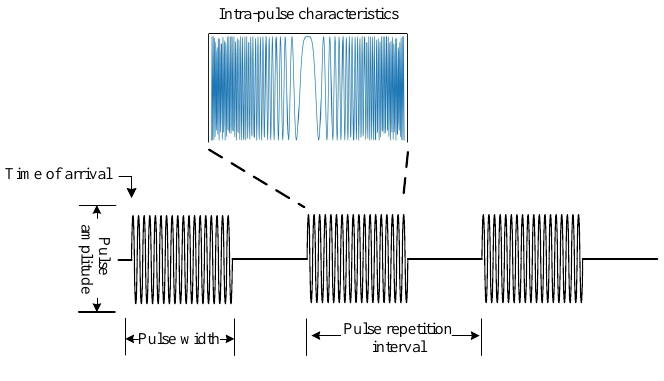
Figure 1. Basic model of radar